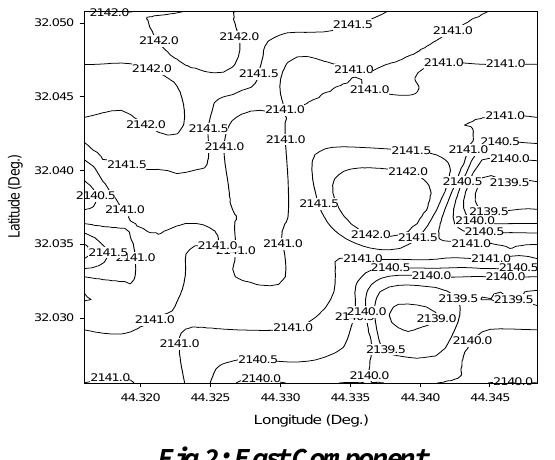
Fig.2: East Component.